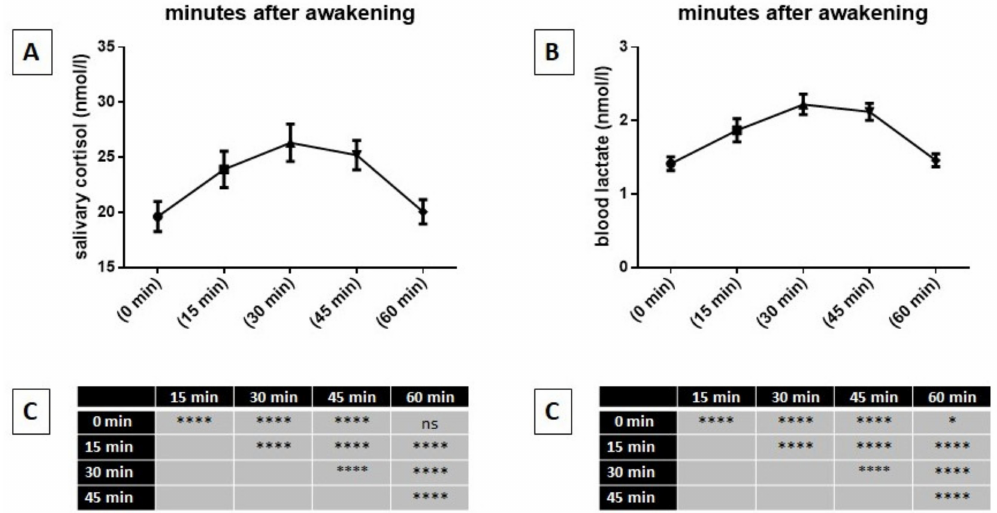
Figure 2. Mean values of profiles of salivary cortisol at awakening of the whole sample ( A ), as well as mean values of blood lactate levels at awakening of the whole sample ( B ) and results of Tukey’s multiple comparisons test between mean values ( C ). Abbreviations: ****, p > 0.0001; ns, not